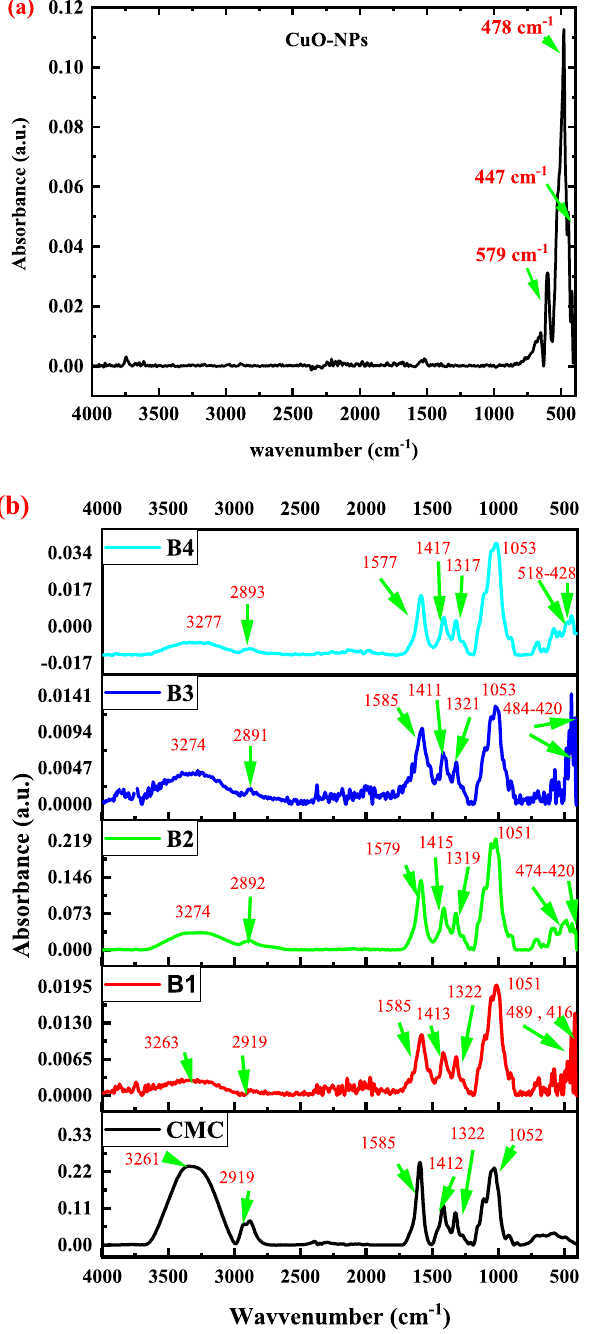
Figure 2. FTIR spectra of ( a ) CuO nanoparticles and ( b ) pure CMC and CMC filled with different concentrations of CuO-NPs (2, 4, 6 and 8